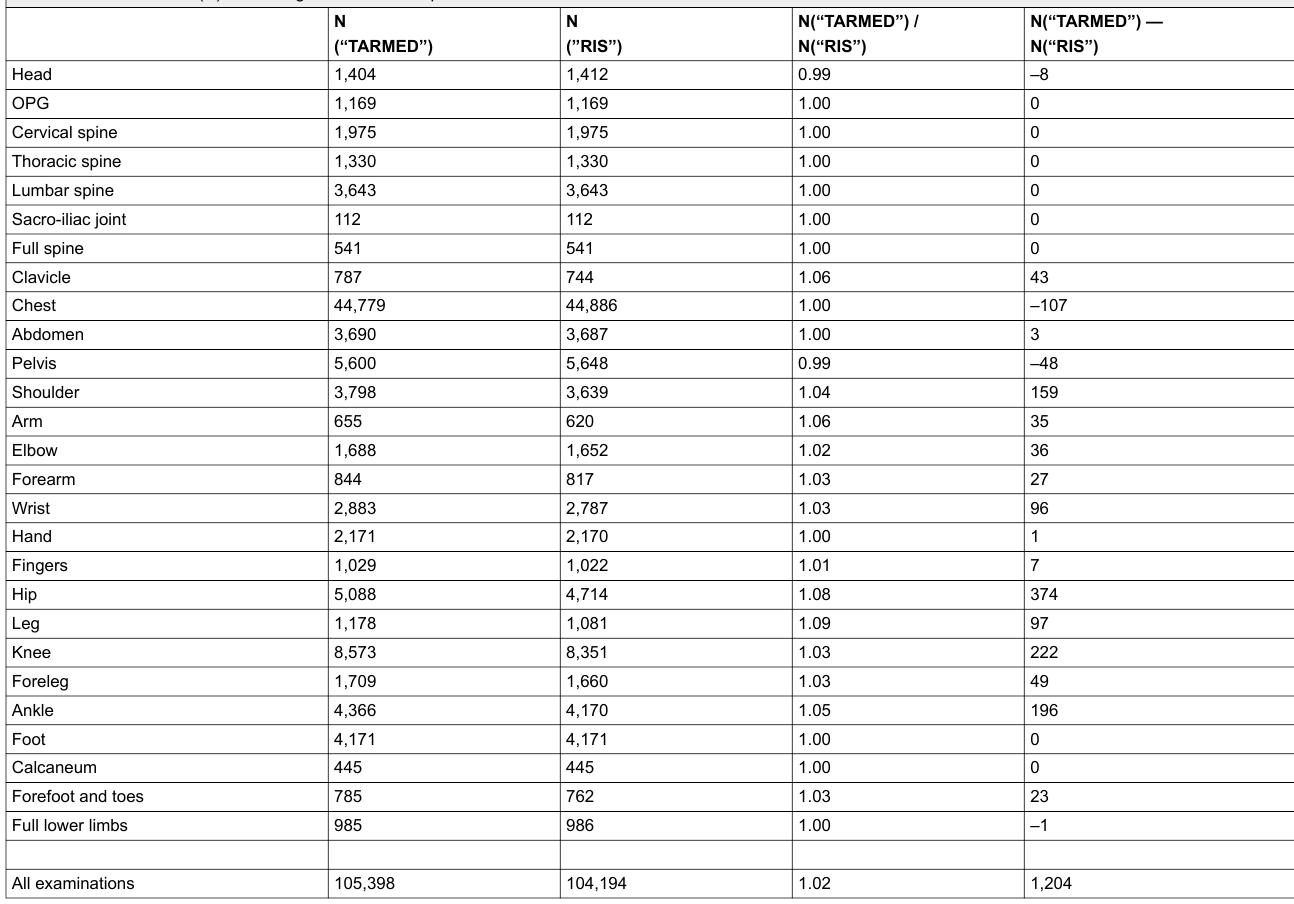
Table 2: Annual number (N) of radiological examination performed in 2008 at CHUV. N